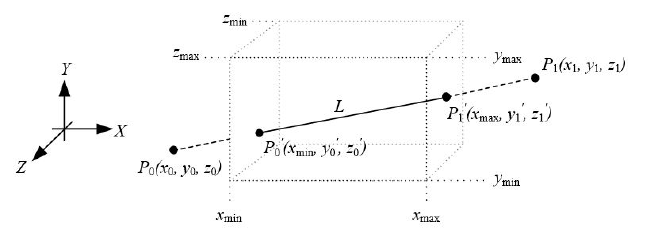
Figure 16. Using the boundary coordinates for the endpoints of the